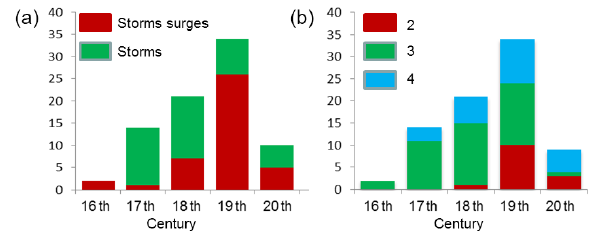
Figure 2. Distribution in time of the type of the events in the data base (a) ; quality of the data (b)